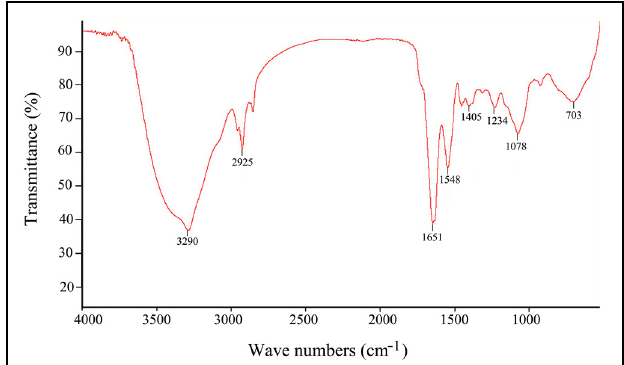
FIGURE 3 | Fourier transform infrared spectrum of the purified EPS273 from P. stutzeri 273 in the range 500–4000 cm − 1 .